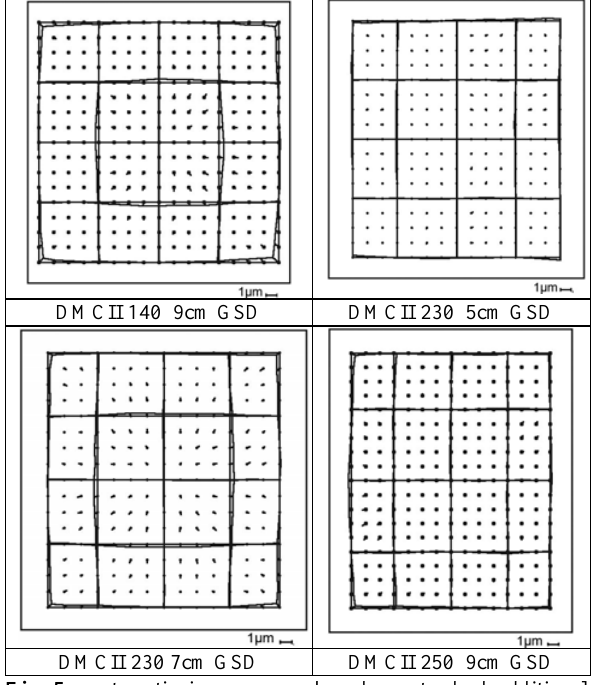
Fig. 5 : systematic image errors based on standard additional parameters 1 - 12